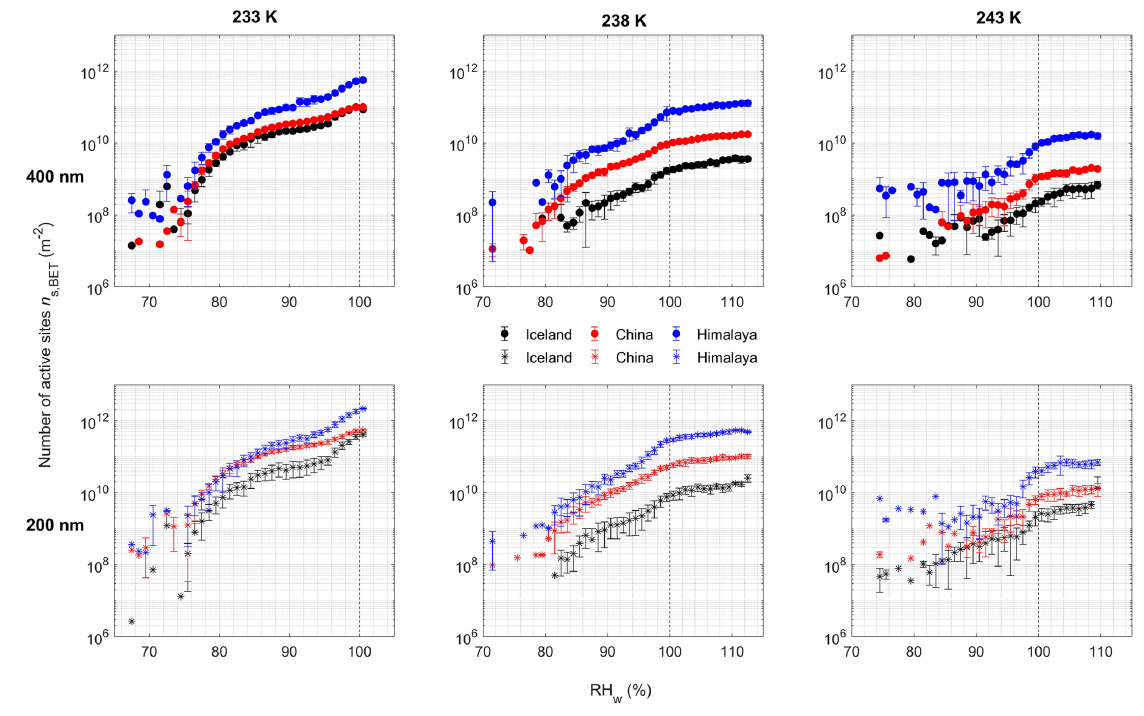
Figure 2. Average n s , BET as a function of RH w for each untreated dust, size and temperature. The values are averaged into 1% RH w bins, and the error bars represent 1 standard deviation. The vertical dashed line is the water saturation (RH w = 100%)